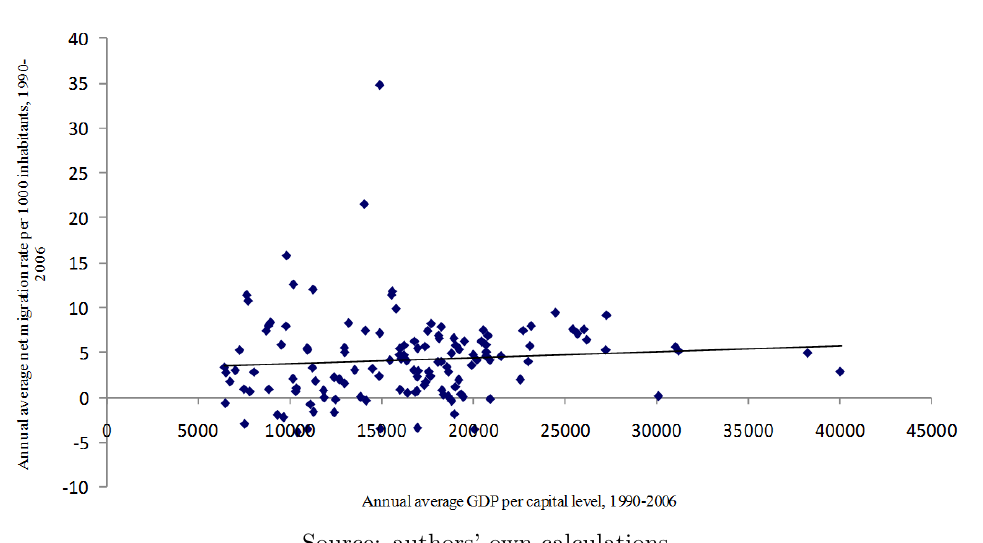
Figure 2: EU-15: Regional living standards and net migration rate 1990-2006